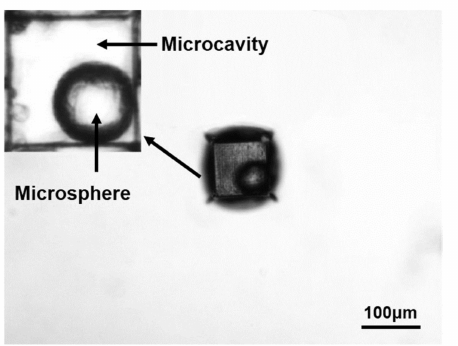
Figure 3. The microcavity and microsphere nested structure inside fused